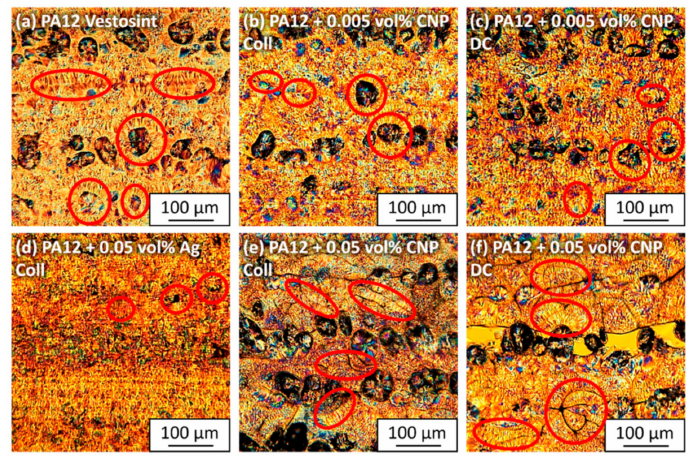
Figure 5. Magnified microscopic polarized images of 10 µ m sliced LB-PBF-P specimens made of ( a ) pure PA12, ( b , c ) PA12 and 0.005 vol% carbon nanoparticles, ( d ) PA12 and 0.05 vol% silver nanoparticles, and ( e , f ) PA12 and 0.05 vol% carbon nanoparticles. PA12 powders were additivated ( b , d , e ) with the colloidal deposition and ( c , f ) with the dry coating method. The images provide